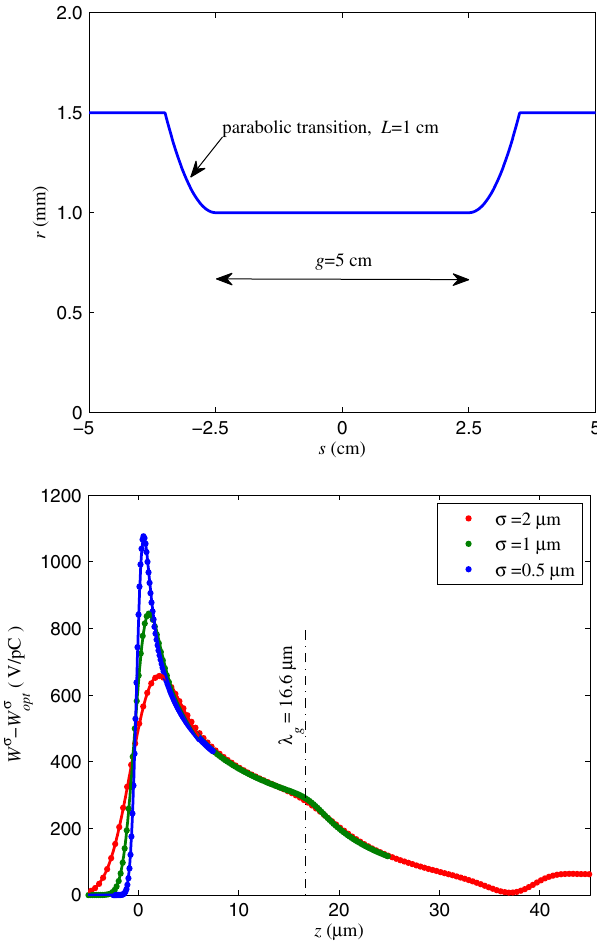
FIG. 11. (top) Smooth collimator geometry; (bottom) wake potentials calculated directly with ECHO (dots) and reconstructed from W 2 (cid:8) m ECHO